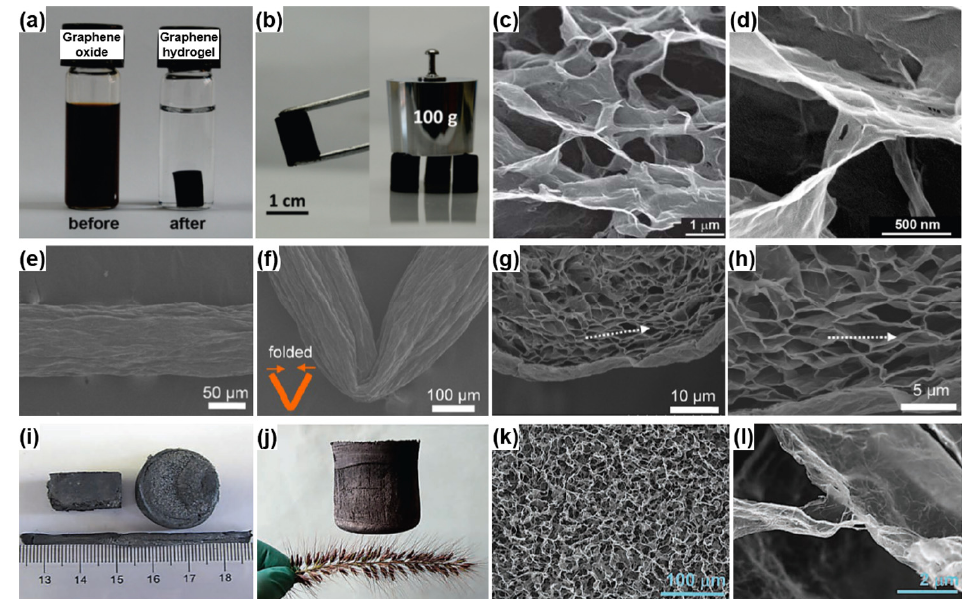
Figure 8. ( a ) Photograph of an aqueous GO dispersion (2 mg ∙ mL − 1 ) before and after hydrothermal reduction at 180 °C for 12 h; ( b ) photographs of a strong rGO hydrogel allowing easy handling and supporting weight; and ( c , d ) SEM images of the rGO hydrogel showing interior microstructures. Reproduced with permission of Ref. [50]; Copyright 2010 American Chemical Society. ( e ) SEM images of the surface of graphene aerogel fibers and ( f ) folded/stretched graphene aerogel fibers; ( g , h ) SEM images of fracture morphology of graphene aerogel fibers. The arrows indicate the alignment direction of graphene sheets. Macroscopic and microscopic structures of UFAs. Reproduced with permission of